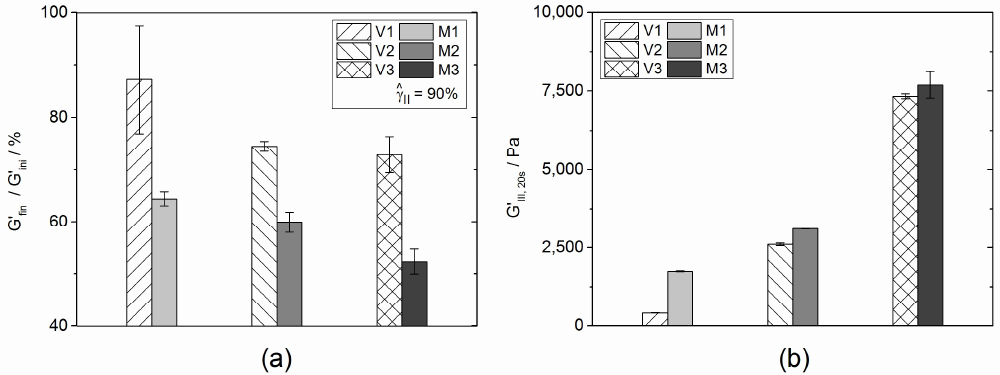
Figure 5. ( a ) Degree of structural recovery for vehicles and silver pastes represented as G ’ fin / G ’ ini determined from oscillatory three-interval thixotropy tests. The applied oscillatory amplitude in Sections I and III is in each case ˆ γ I,III = 0.05% and in Section II ˆ γ II = 90%; ( b ) Absolute degree of recovery G ’ III,20 s after 20 s rest time in section III at ˆ γ III = 0.05%. Patterned bars correspond to vehicles, filled bars represent silver